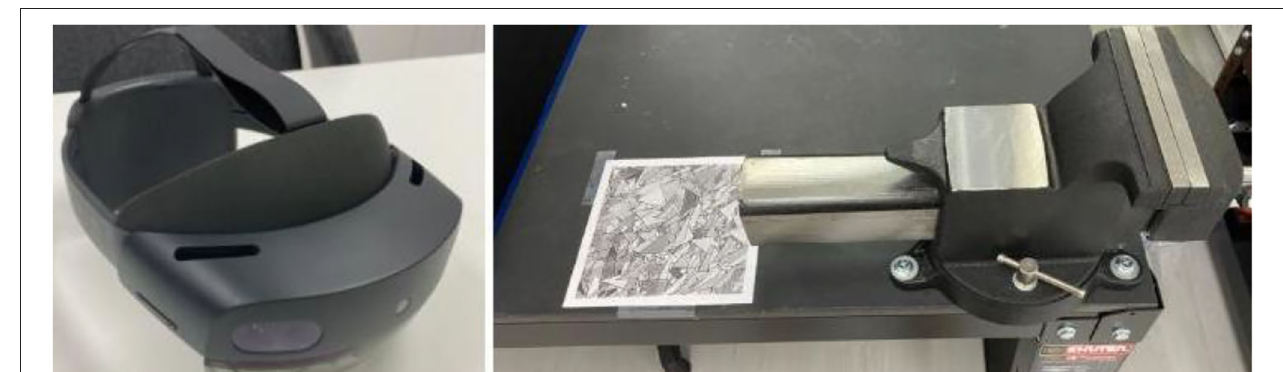
Frontiers in Psychology |